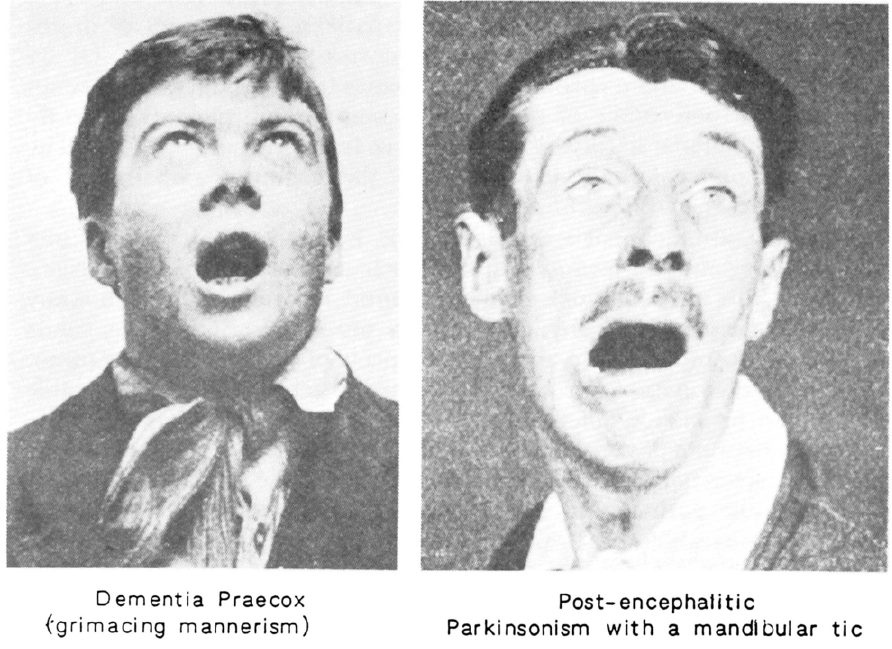
FIG. 2. Conflicting views of the same disorder- illustrations from contemporary text books (Norman, 1928; Wilson,